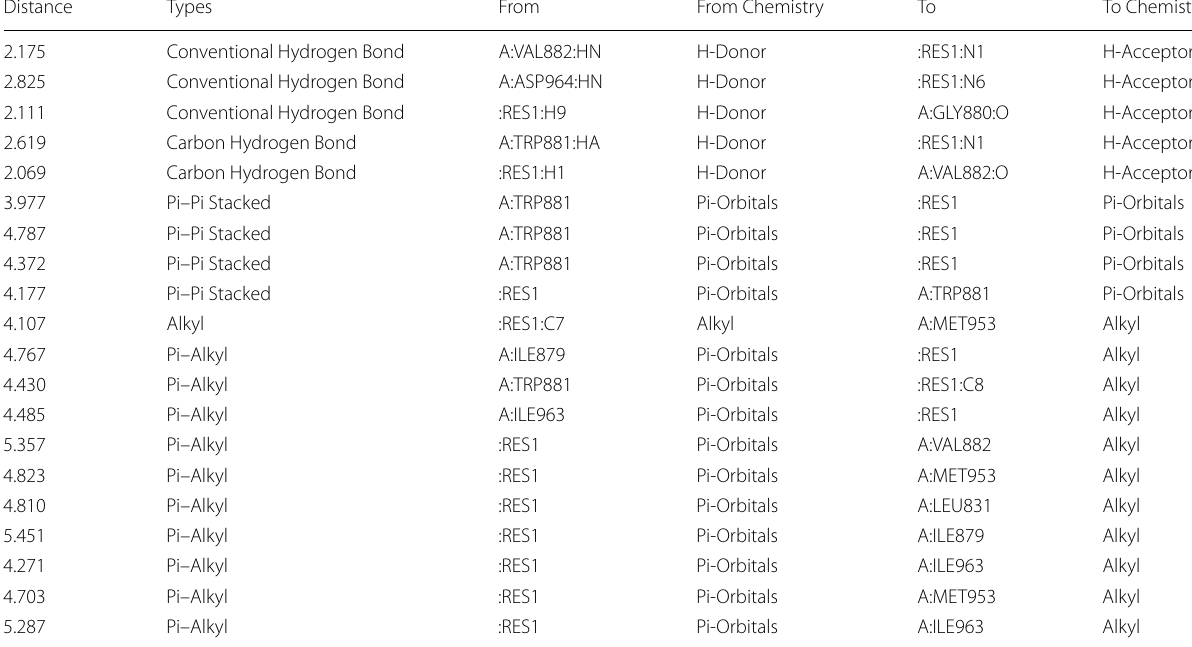
Table 6 Types of interactions in the INK–4JT6 (mTOR) receptor complex